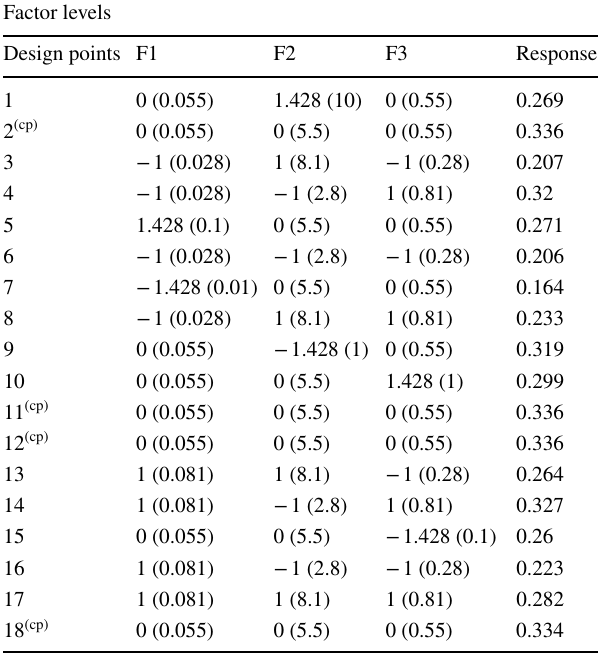
Table 2 List of experiments in the CCD for model optimization: coded and (actual)